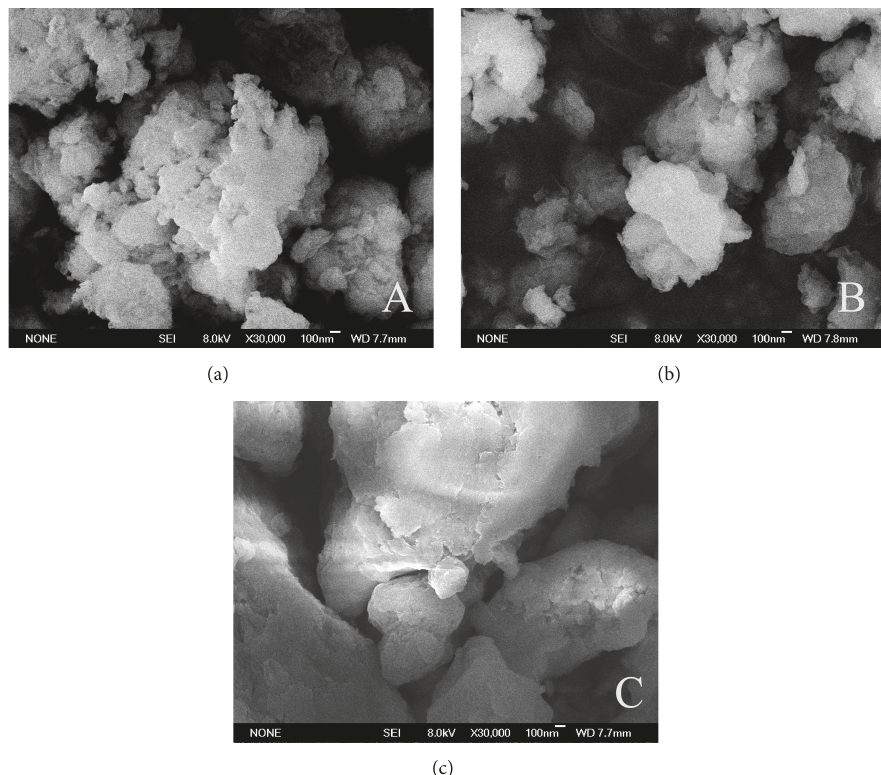
Figure 2: SEM of LDHs samples ((a) MgAl-LDHs, (b) MgFe-LDHs, and (c) MgAlFe-LDHs).